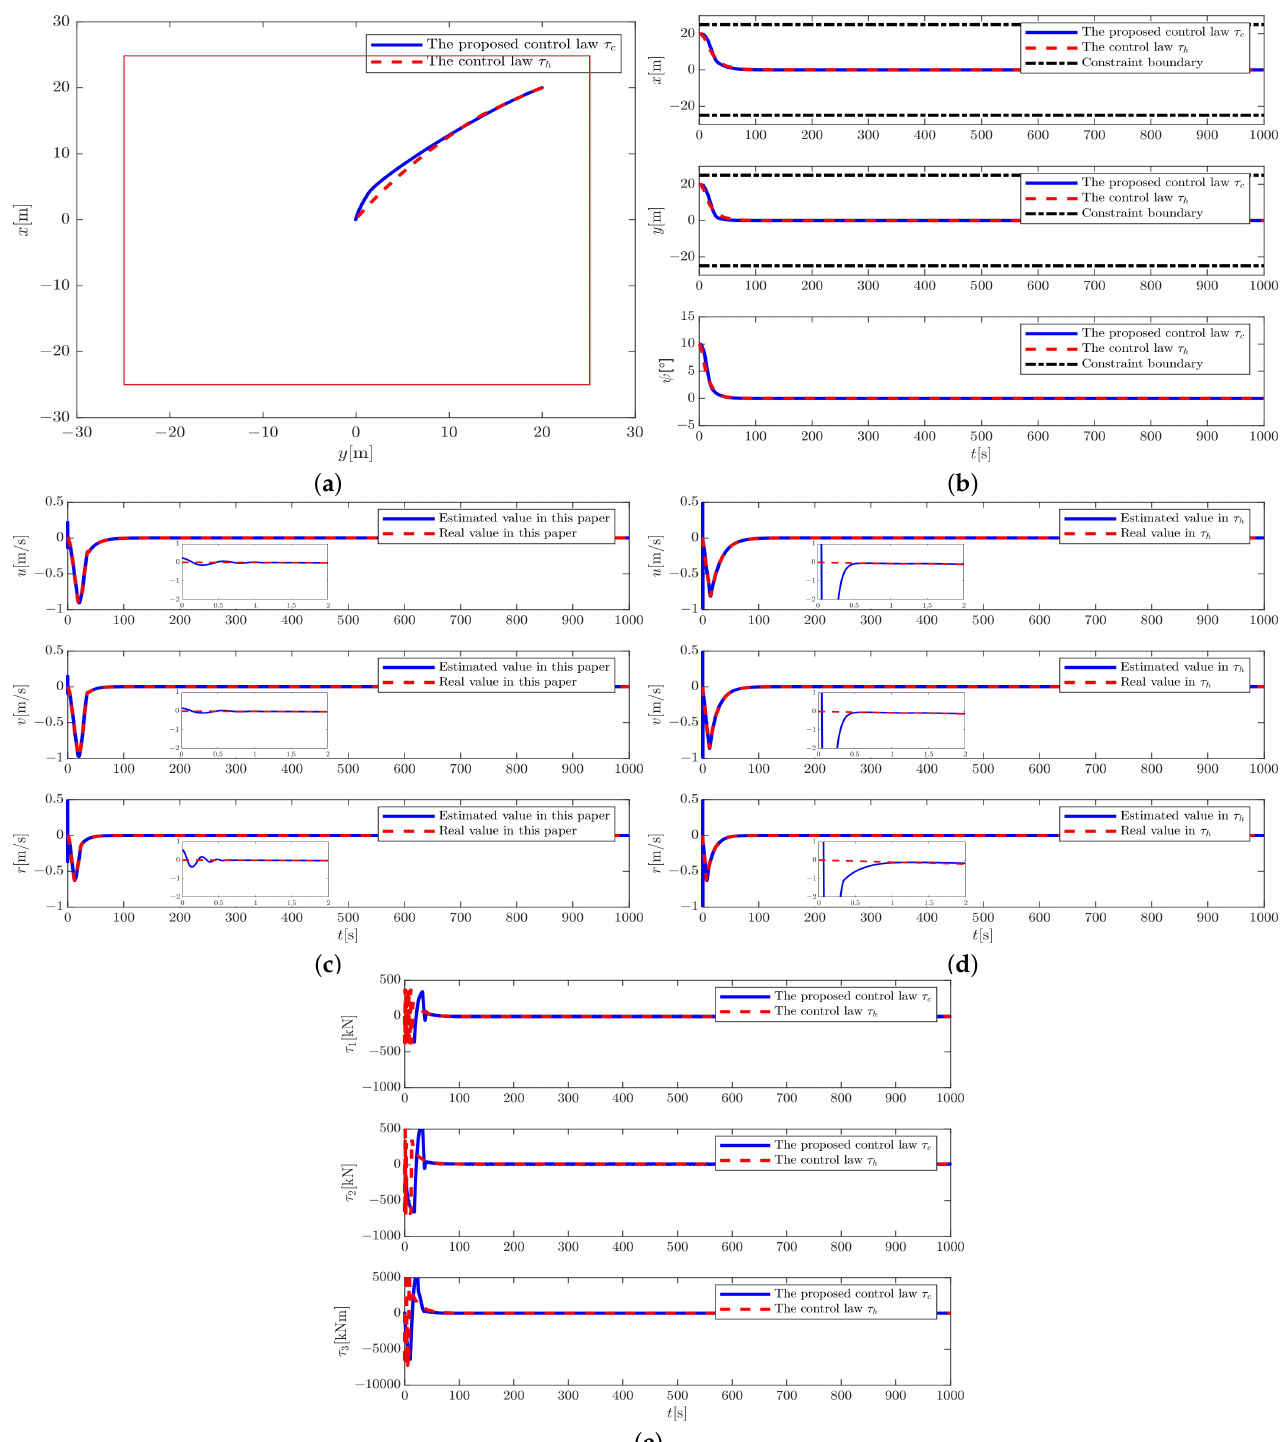
Figure 6. Simulation comparison between this paper and paper [46] for dynamic positioning output feedback control strategy with MSS toolbox: ( a ) ship horizontal motion trajectory; ( b ) ship position and heading; ( c ) comparison between the observed speed of FDESO proposed in this paper and the real speed; ( d ) comparison between the observed speed of high-gain observer proposed in [46] and the real speed; ( e ) comparison between the actual thrust generated by the ship thruster in this paper and in